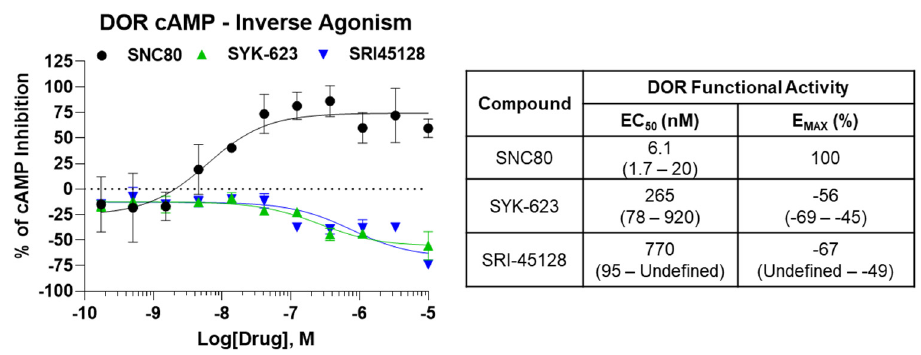
Figure 3. SRI-45128 caused DOR inverse agonist activity. SRI-45128, positive control SYK-623, and SNC80 reference compounds were used to modulate the cAMP accumulation caused by forskolin treatment (see Methods). One independent experiment in triplicate was performed, and the potency (EC 50 ) and efficacy (E MAX ) were reported as the derived value with 95% confidence intervals (in parentheses). As expected, SNC80 caused high potency and efficacy cAMP inhibition, which is consistent with DOR agonist activity. SRI-45128 and SYK-623 caused efficacious cAMP increases, which is contrary to DOR agonism and consistent with DOR inverse agonism.